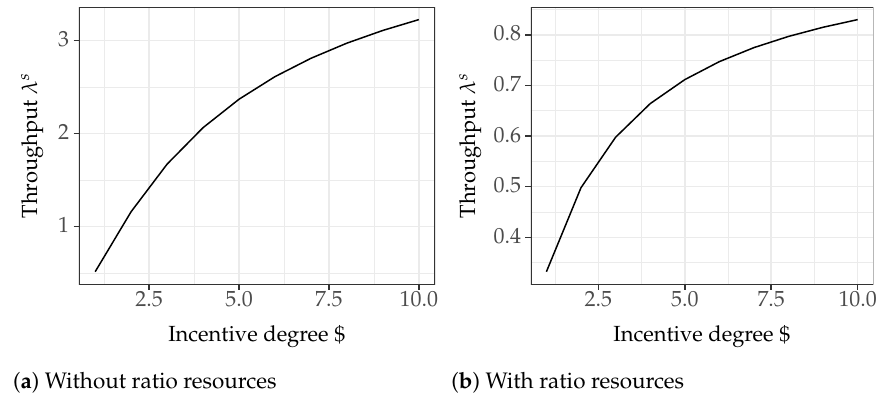
Figure 7. Incentive schemes versus throughput.